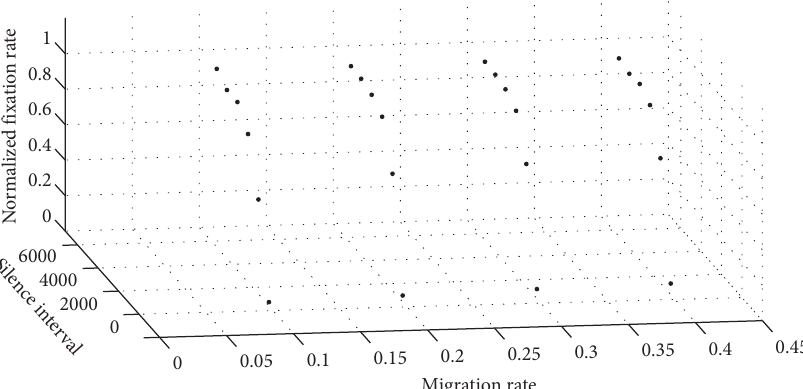
Figure 9: The relationship between the normalized fixation rate of the A migration rate parameter in a spatial